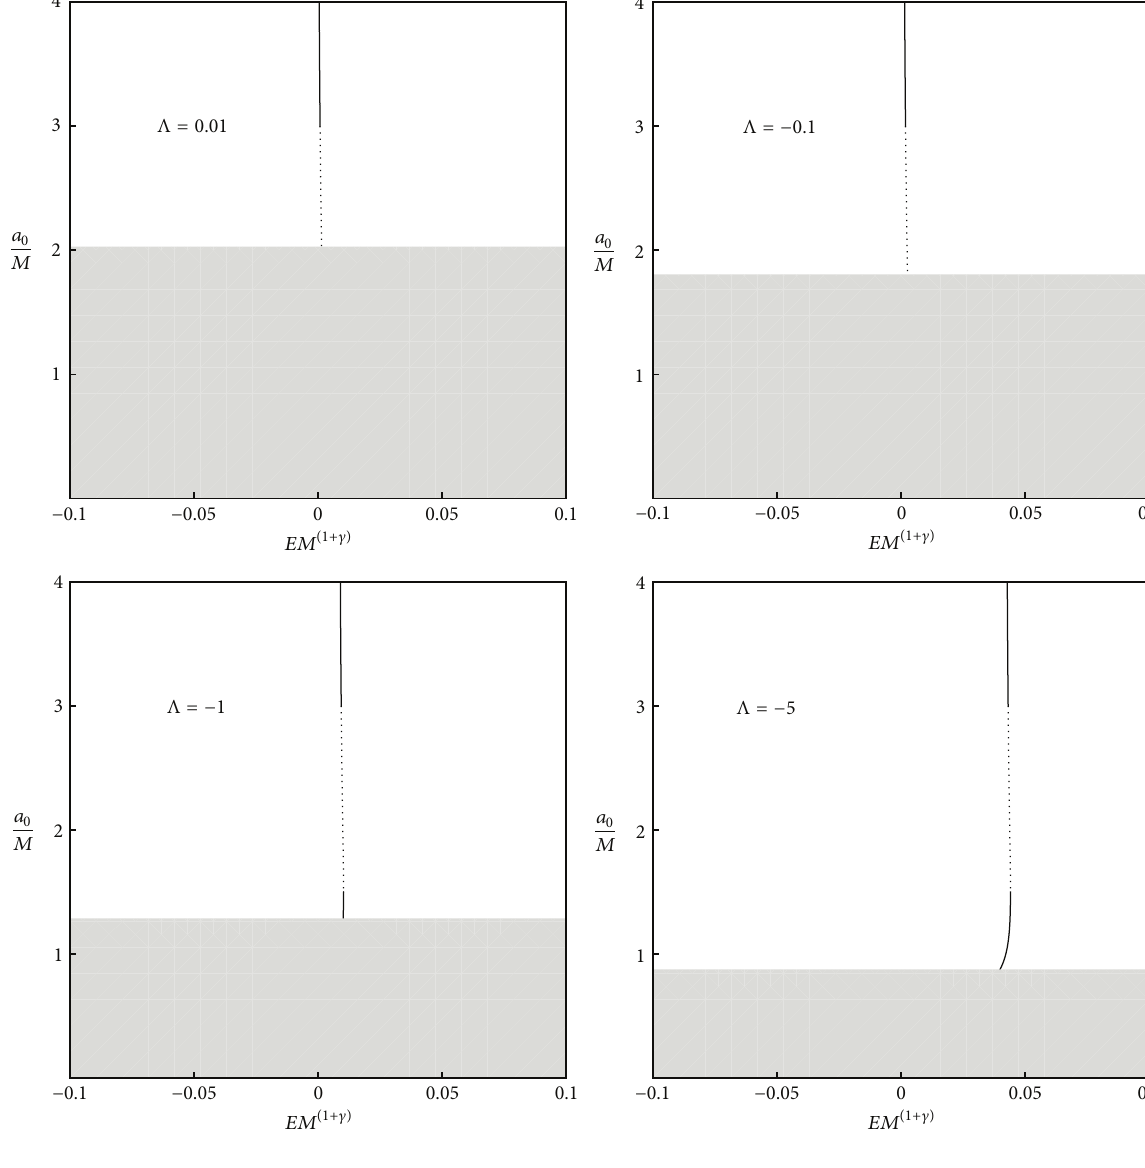
Figure 6: Plots corresponding to GCCG with 𝛾 = 1 , 𝑀 = 1 , and 𝑤 = −10